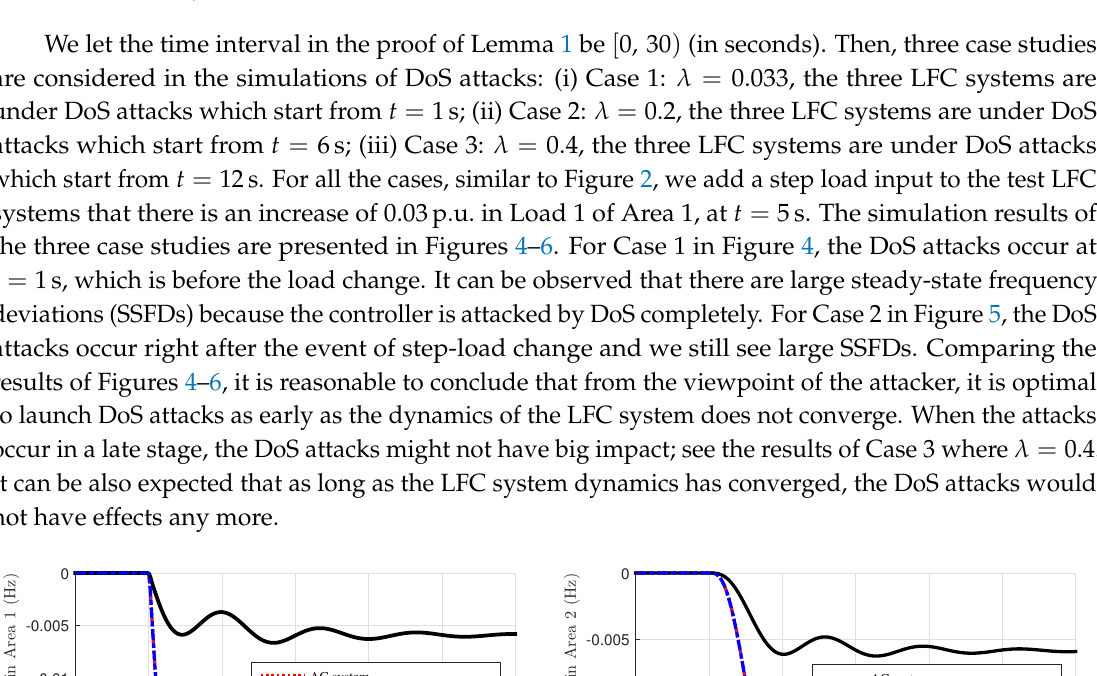
Figure 3. The maximum real part of the eigenvalues of Φ ( λ ) = Φ λ control (LFC) systems.